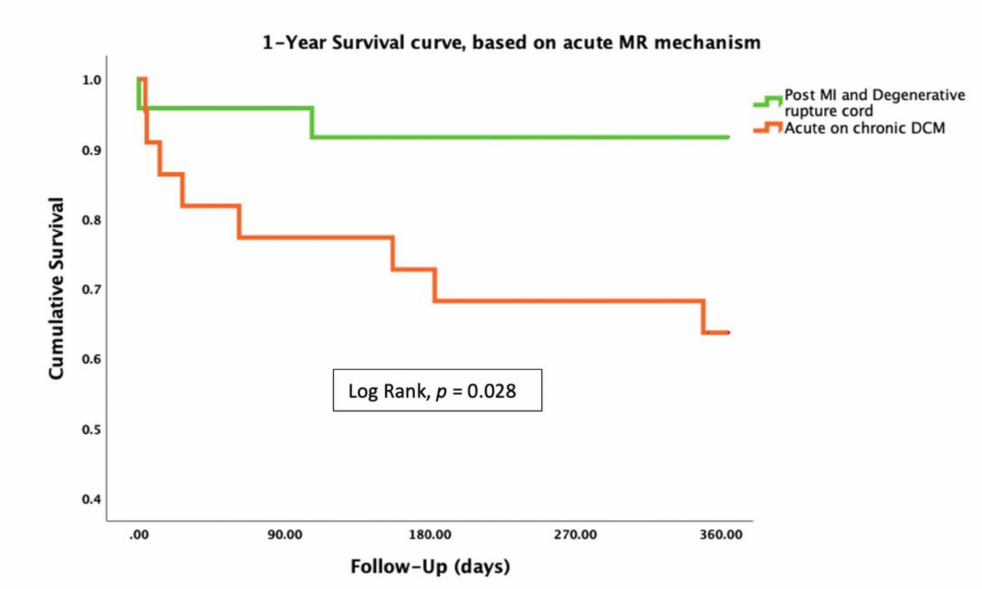
Figure 4. Kaplan–Meier survival analysis of 46 ADHF patients who underwent PMVr for severe MR between 2015 and 2020 by MR etiology. p -value for log rank test. PMVr = percutaneous mitral valve repair; ADHF = acute decompensated heart failure; MR = mitral regurgitation; MI = myocardial